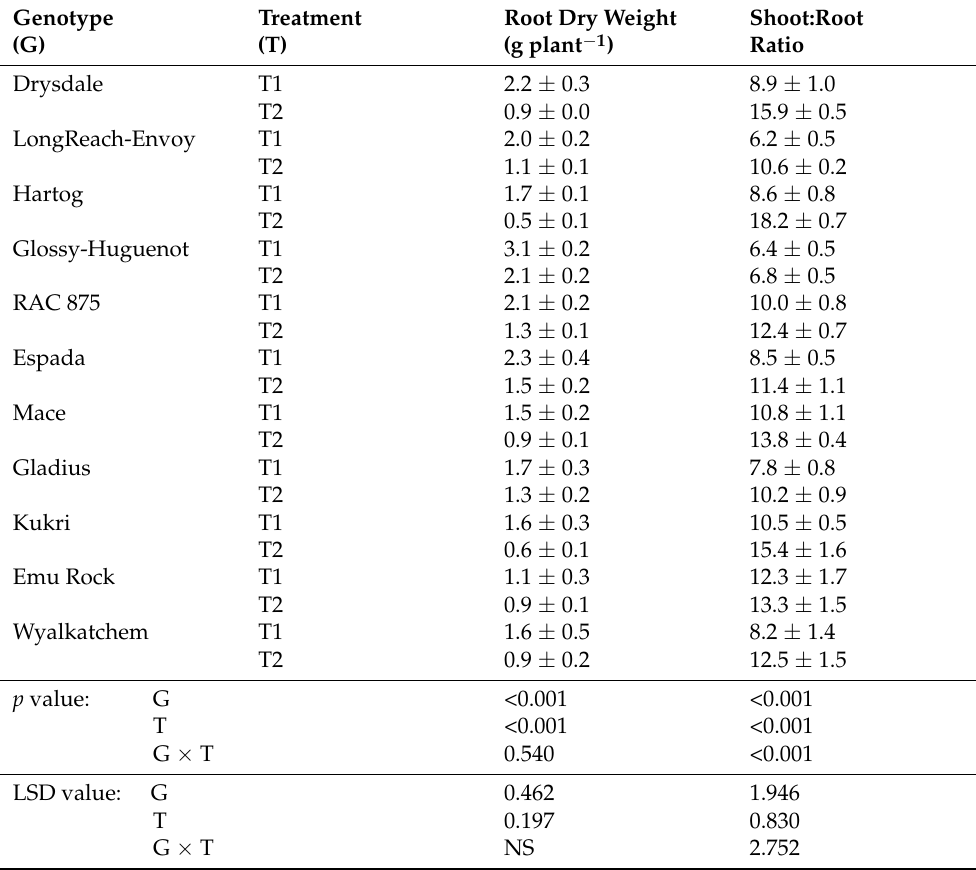
Table 3. Root dry weight and shoot:root ratios of 10 wheat genotypes in Batch 02 under ambient (T1) and high (T2) temperature regimes. Values presented are means ± SEM, n =